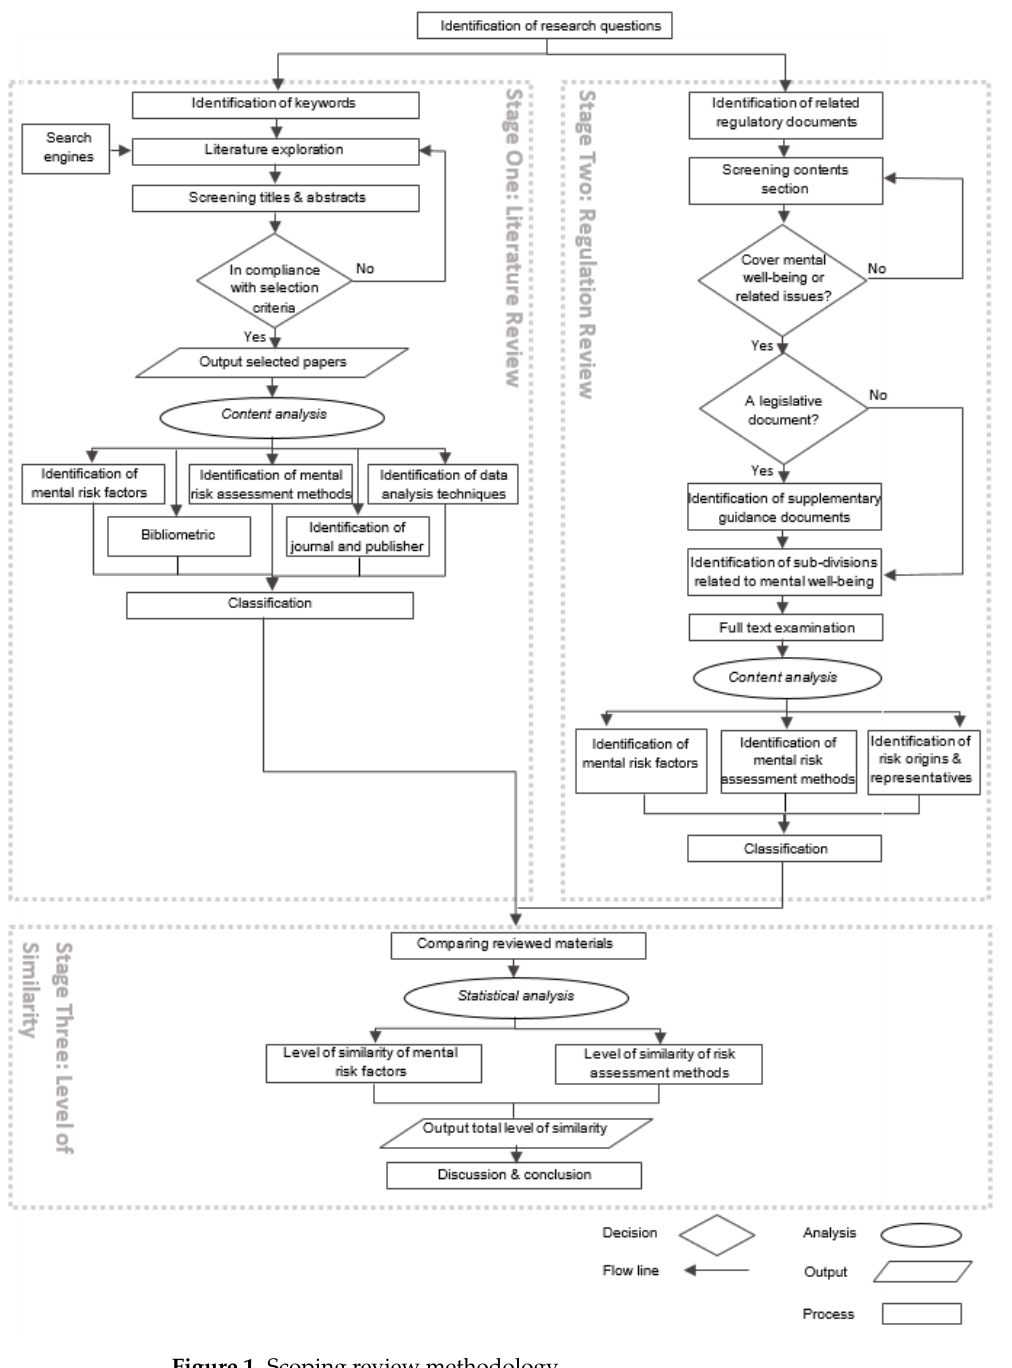
Figure 1. Scoping review methodology.